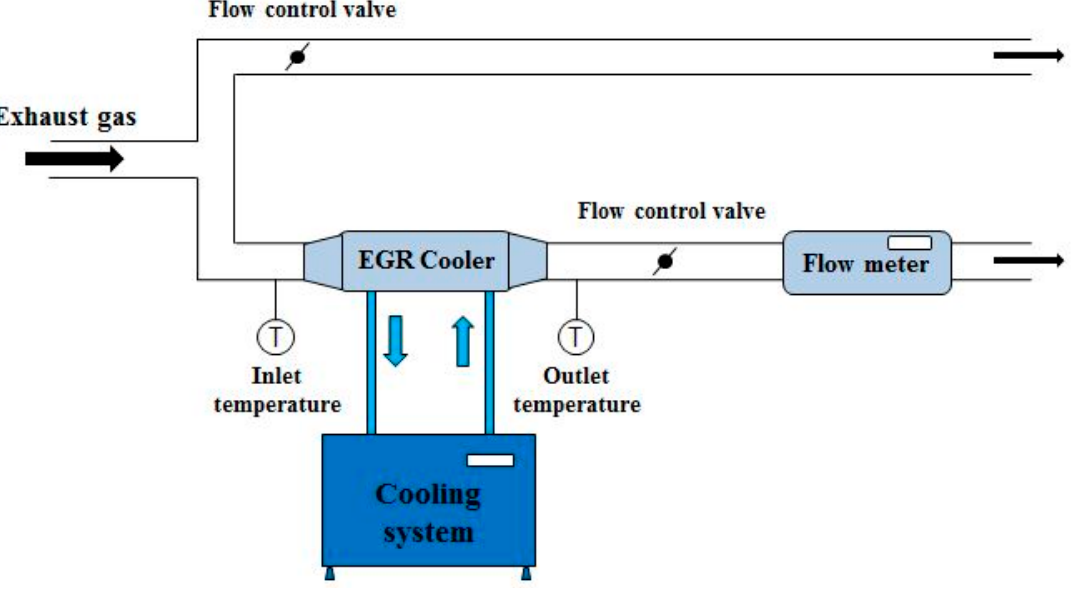
Figure 2. Schematic diagram of engine-bench experimental system.